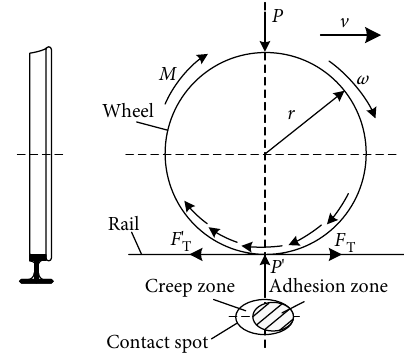
Figure 1: Wheel/rail adhesion-creep phenomenon.